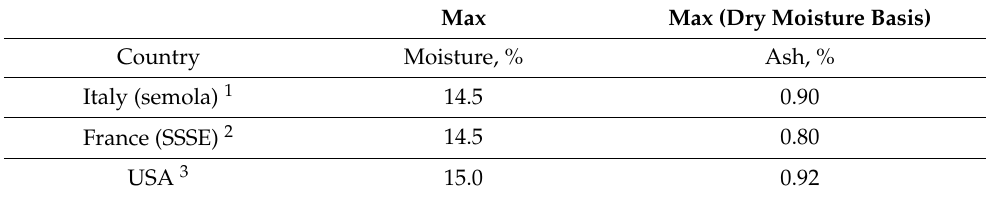
Table 6. Semolina ash content